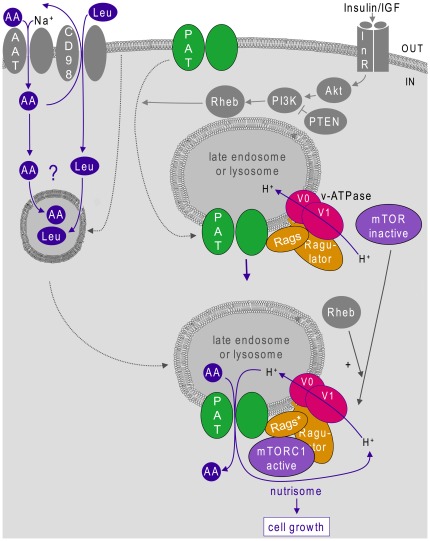
AA-dependent regulation of mTORC1in late endosomes and lysosomes via the PAT1/Rag/Ragulator/v-ATPase nutrisome complex.We have shown that Proton-assisted Amino acid Transporters (PATs) localised on late endosomes and lysosomes (LELs) interact with Rag GTPases (Rags) and are required for mTORC1 activation. The Ragulator is a trimeric group of proteins involved in attaching the complex to the lipid bilayer. Recent studies [41] have also demonstrated that the vacuolar H+-ATPase (v-ATPase) interacts with the activated Rag (Rag*)/Ragulator complex to control amino acid (AA)-dependent mTORC1 activation and that this is regulated by the rapid accumulation of extracellular AAs in LELs. This suggests a model where, in response to AAs (compare upper LEL to lower AA-stimulated LEL), these different molecules form a complex that we call the ‘nutrisome’. Cycling of protons through this nutrisomal engine induces conformational changes that activate mTORC1, leading to increased translation and cell growth. Importantly, signalling from the insulin receptor (InR) and subsequent activation of the PI3K/Akt/Rheb cascade promotes shuttling of PATs from the cell surface to LEL membranes, hence increasing PAT-dependent mTORC1 activation and cell growth. In addition, the accumulation of AAs in the LEL lumen presumably involves transport into intracellular endosomal compartments (depicted by compartment on left hand side) via currently unknown amino acid transporters (AATs) or potentially endocytosis. Cytoplasmic leucine (Leu), which may be brought into cells via the heterodimeric AAT, CD98 [34], has been shown to play a key role in activating mTORC1 in some cultured cells and may play a key role in this process. Influx of Leu or other AAs into the endolysosomal system may ultimately allow the AA substrates of PAT1 to accumulate in the LELs through AA exchange mechanisms, leading to PAT1-mediated activation of the nutrisome. Interactions leading to activation or inhibition of downstream components are depicted by solid arrows and solid bars respectively, movement of specific molecules by dashed arrows and processes involving membrane shuttling by dotted arrows.